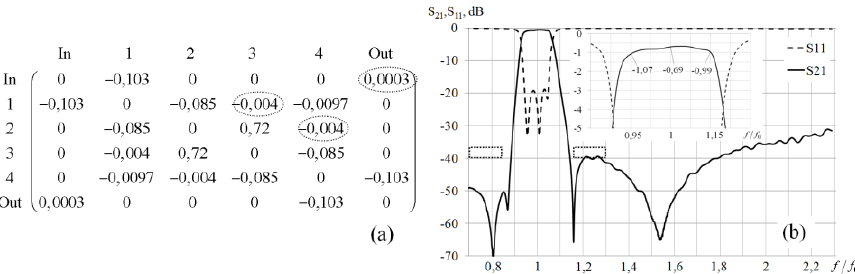
Fig. 10. Refined coupling matrix of the proposed QEF on MCB (a), measured S -parameters in a wide frequency band